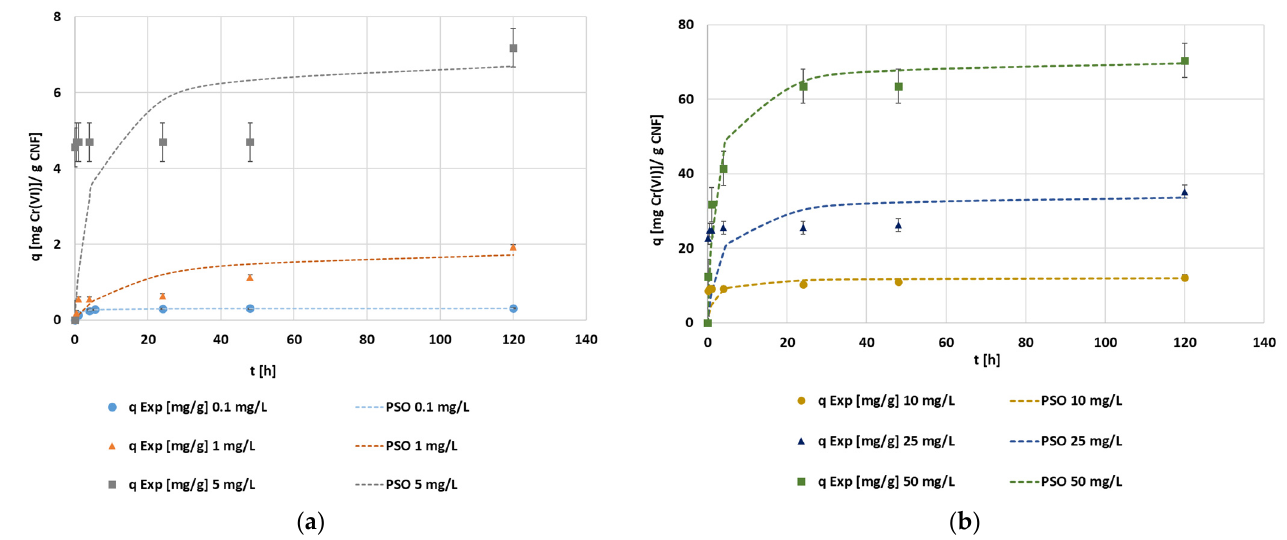
Figure 12. ( a ) The evolution of the kinetic adsorption experiment of the CNF hydrogel at 1000 mg·L − 1 of dosage, 1.5 mmol MTMS·g − 1 CNF, and pH 3 conditions under 0.1 to 5 mg·L − 1 ; ( b ) 10 to 50 mg·L − 1 of the initial hexavalent chromium concentration and kinetic fitting of the pseudo-second order model.